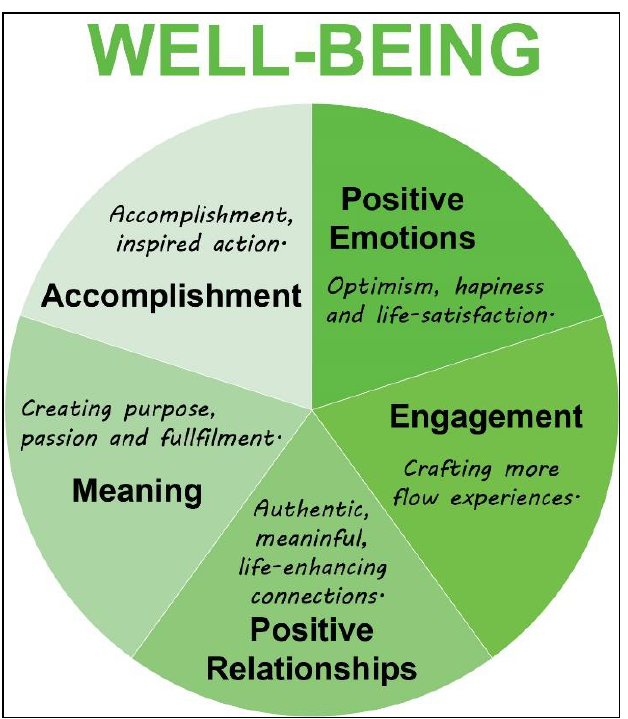
Figure 20. PERMA model for Seligman ’ s well-being theory. Source: [126]. Adapted by the author.